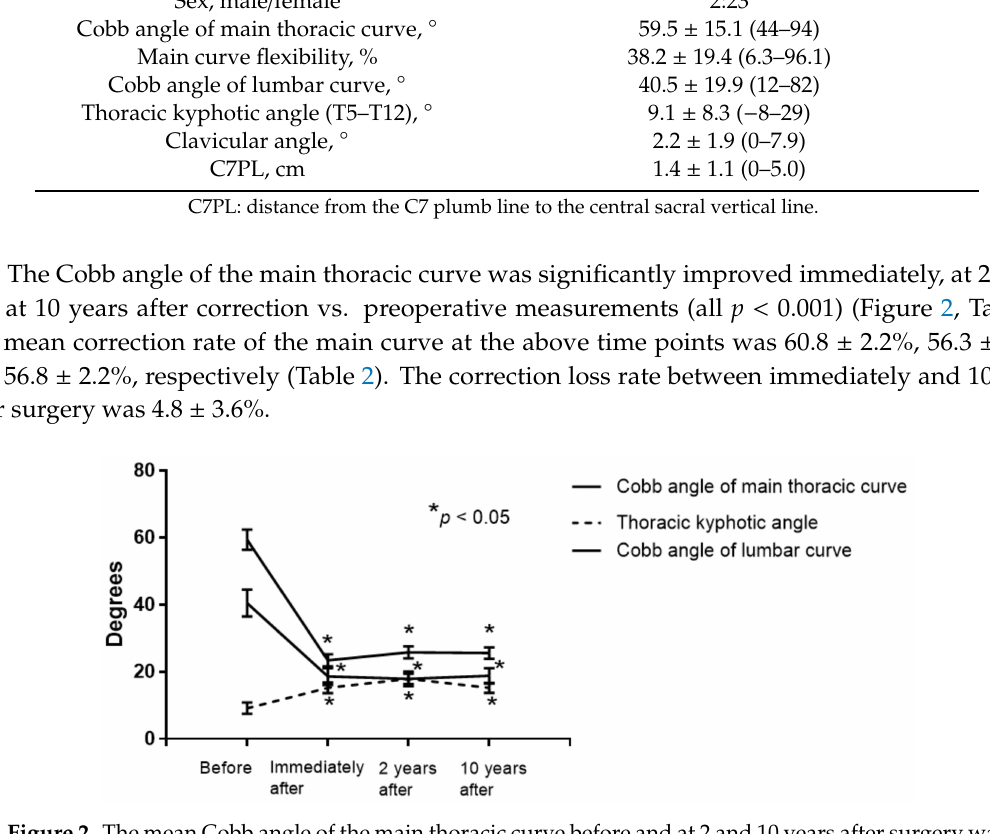
Figure 2. The mean Cobb angle of the main thoracic curve before and at 2 and 10 years after surgery was 59.4 ◦ , 25.8 ◦ , and 25.6 ◦ , respectively. The main thoracic curve Cobb angle was significantly improved at both post-operative time points ( p < 0.001). The respective mean T5–12 thoracic kyphotic angle before and at 2 and 10 years after surgery was 9.1 ◦ , 17.9 ◦ , and 15.2 ◦ . The Cobb angle of the lumbar curve was